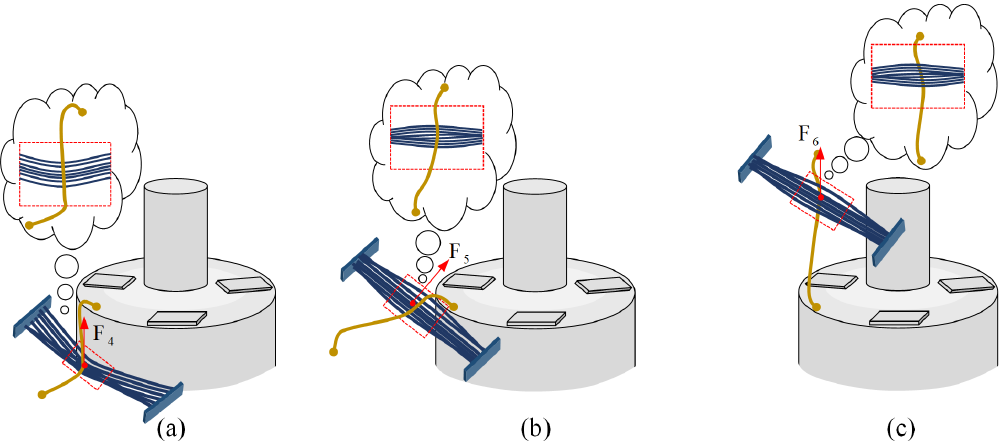
Figure 5. Three states in the working process of the vertical brush: ( a ) The state of the vertical brush in contact with the winding sidewall. ( b ) The instantaneous state of the vertical brush off the surface of the winding sidewall. ( c ) The state of the vertical brush with an adjusted wire attitude.